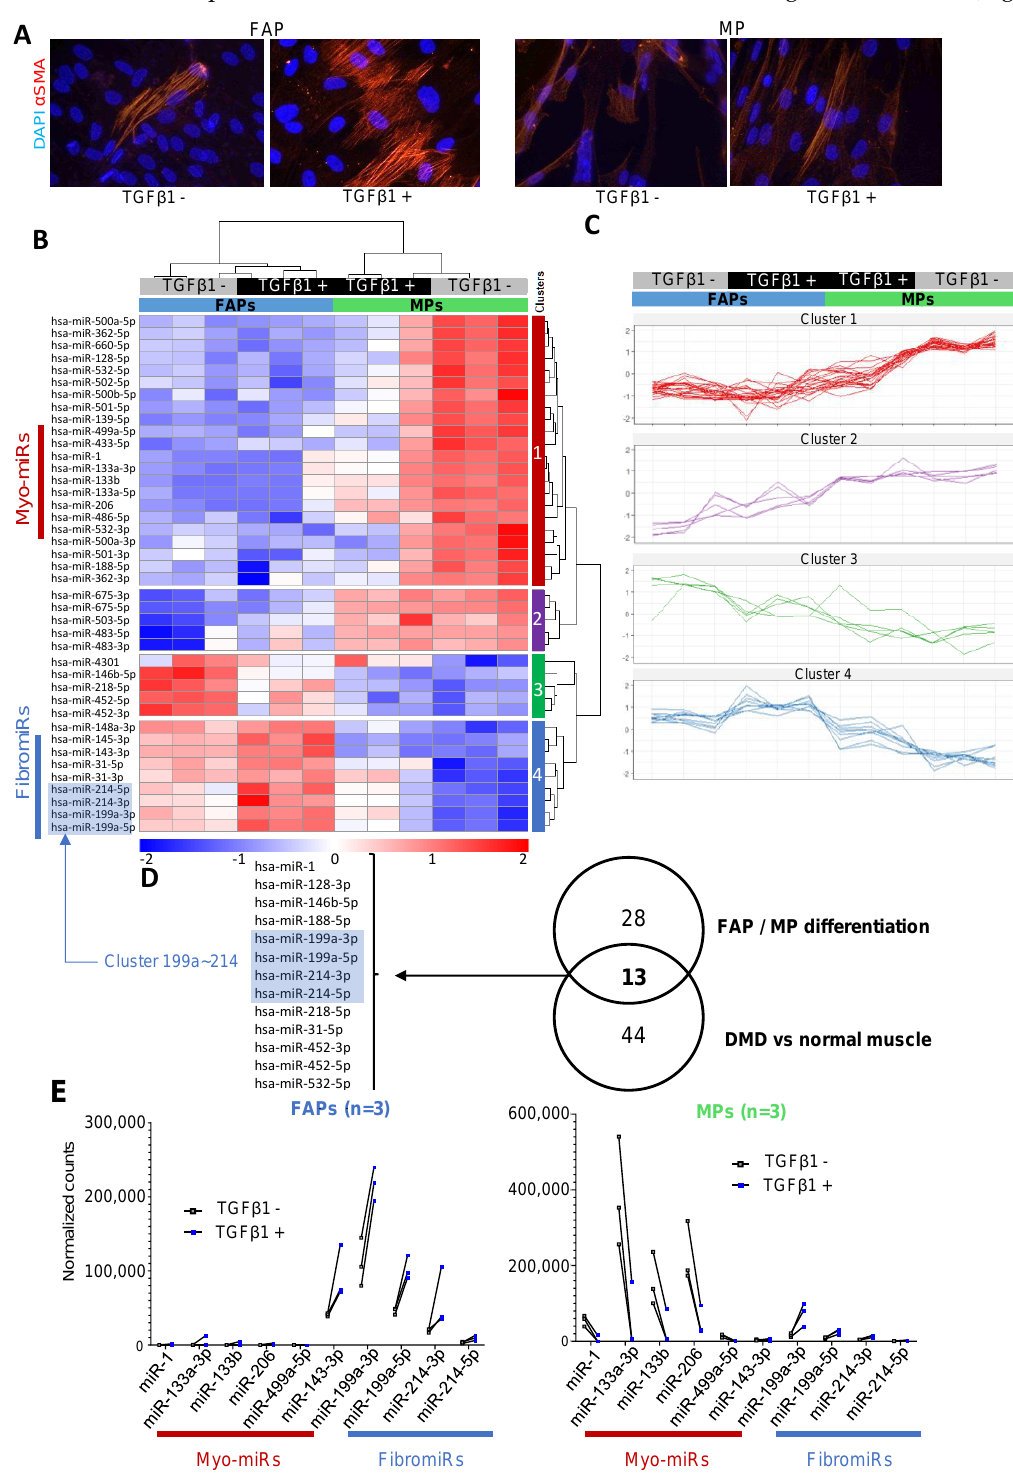
Transient transfection with fibromiR inhibitors was performed in the presence or absence of TGF β 1. While LNA-199a-3p or LNA-199a-5p did not show reduction in COL1A1 , FN1 and ACTA2 expression profiles compared to a control inhibitor (LNA- CT), LNA-214-3p strongly affected the three fibrotic markers (Figure S7). Knockdown of miR- 214-3p was repeated in FAP cells cultured in TGF β 1-induced fibrogenic conditions (Figure 3).